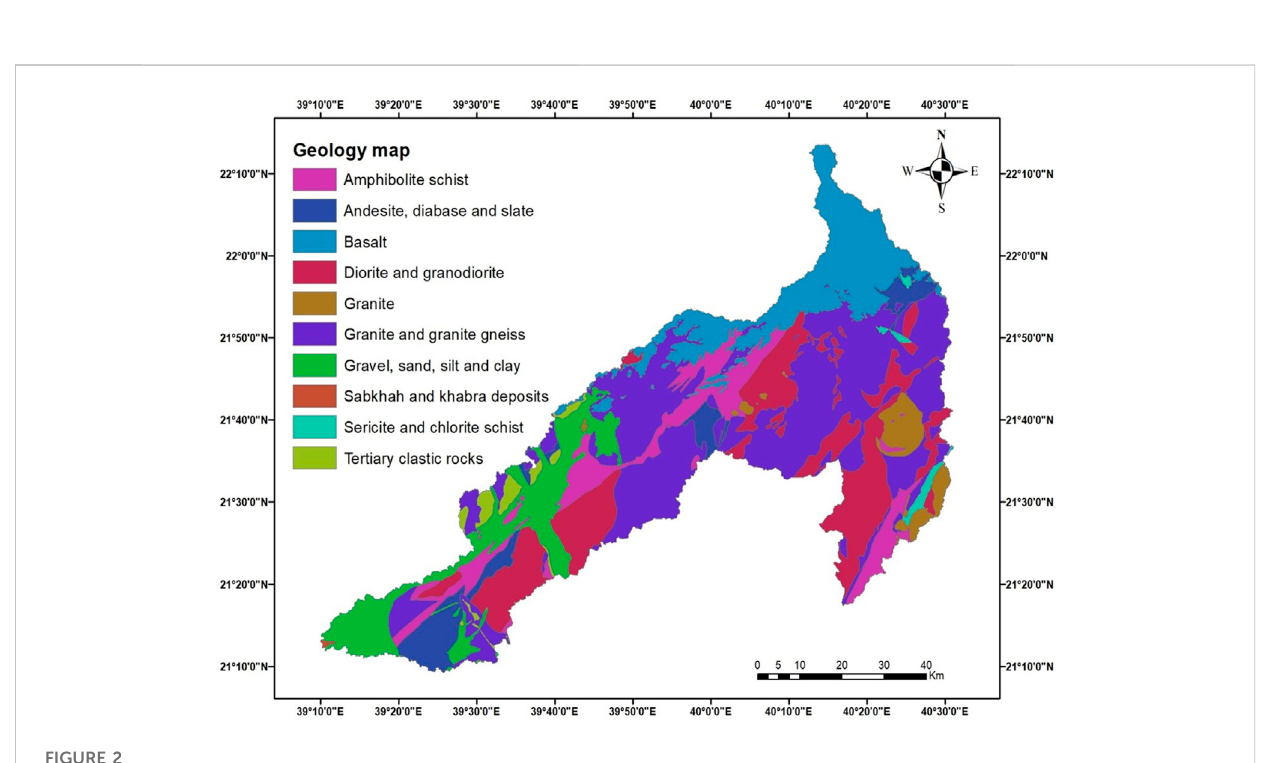
FIGURE 2 Geology map of Wadi